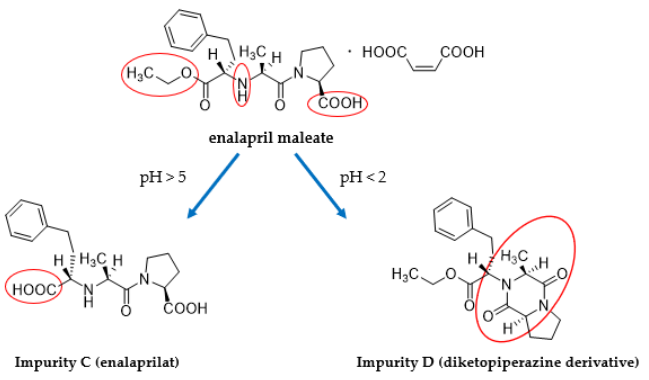
Figure 1. Illustration of the main degradation products of enalapril maleate [5].